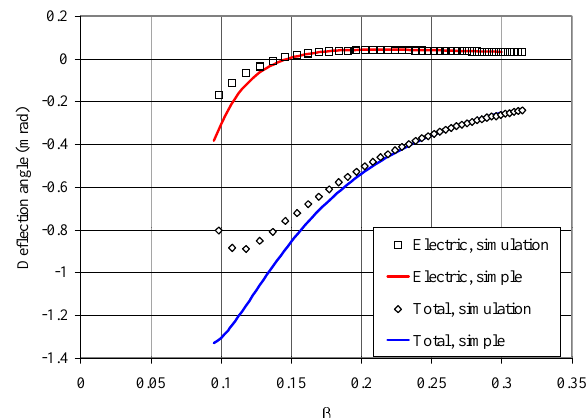
FIG. 6. (Color) Proton beam deflection angle in 115 MHz QWR calculated by simplified Eqs. (6)–(8) and ray-tracing code TRACK . The upper curve corresponds to electric steering and the bottom curve to the total steering. The TRACK simulations are shown by discrete symbols.